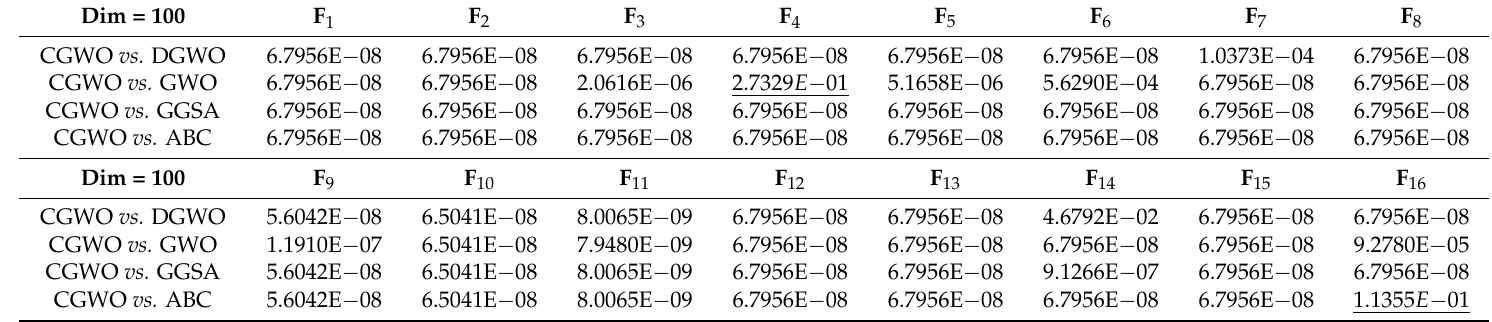
Table 9. p -values produced by Wilcoxon rank-sum test comparing CGWO vs. DGWO, GWO, GGSA, and ABC at Dim = 100 ( p ě 0.05 have been underlined). Dim =